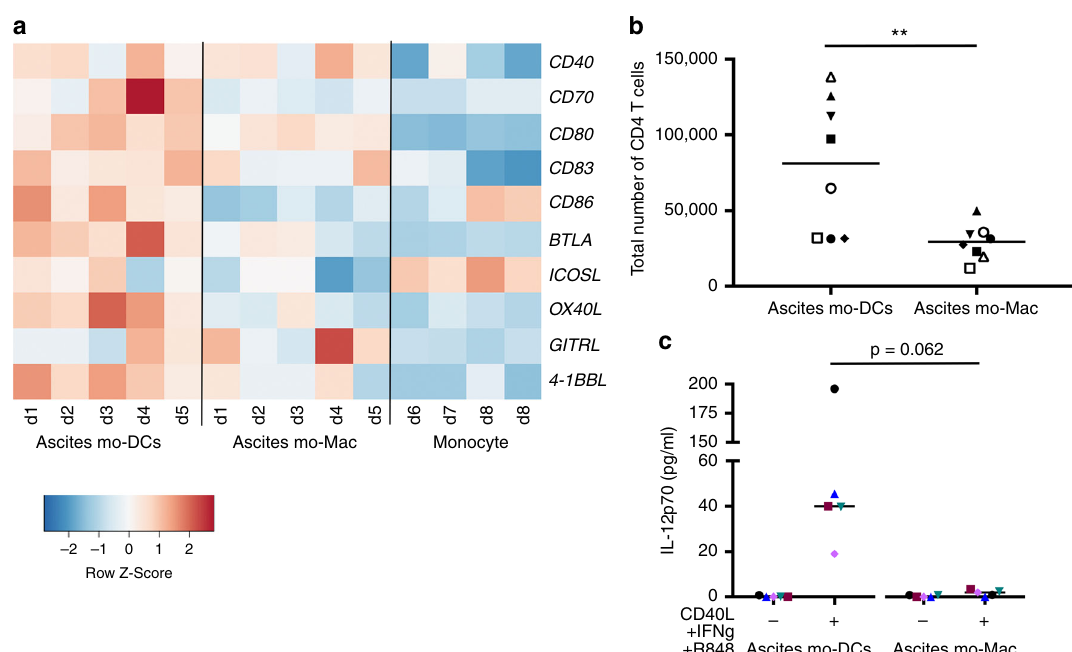
Fig. 7 Human mo-DCs, but not mo-Mac, provide co-stimulatory signals for the differentiation of cytotoxic CD8 + T cells. a Heatmap of scaled expression for selected co-stimulation genes. d donor. b Puri fi ed DCs and macrophage from tumor ascites were cultured with allogeneic naïve CD4 + T cells for 7 days, in the presence of naïve CD8 + T cells. Total number of live CD4 + T cells at the end of the culture is depicted. N = 8. c Puri fi ed DCs and macrophage from tumor ascites were cultured in the absence or presence of CD40-L, IFN- γ , and R848 for 24 h. Secretion of IL-12p70 was measured in the supernatant. N = 5. b , c Symbols represent individual donors. Median is shown. ** p < 0.01, Wilcoxon non-parametric